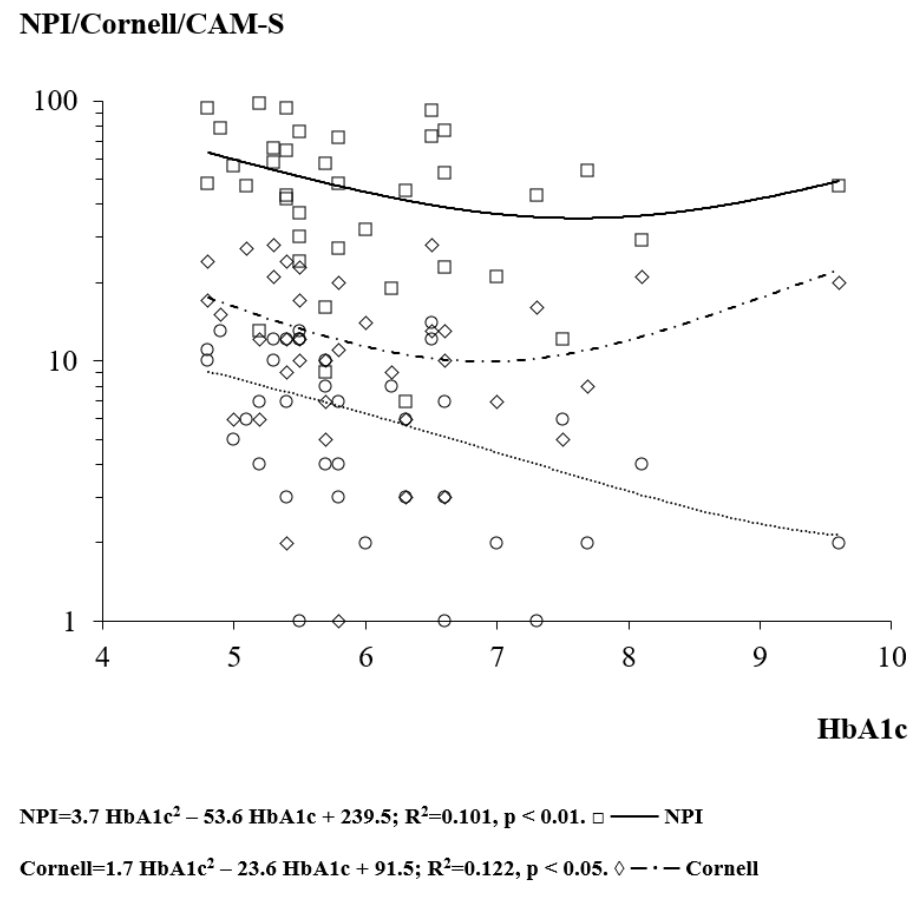
Figure 2. The relationship between the glycated haemoglobin (HbA1c) and the Neuropsychiatric Inventory (NPI), Cornell’s scale and Confusion Assessment Method-severity (CAM-S)